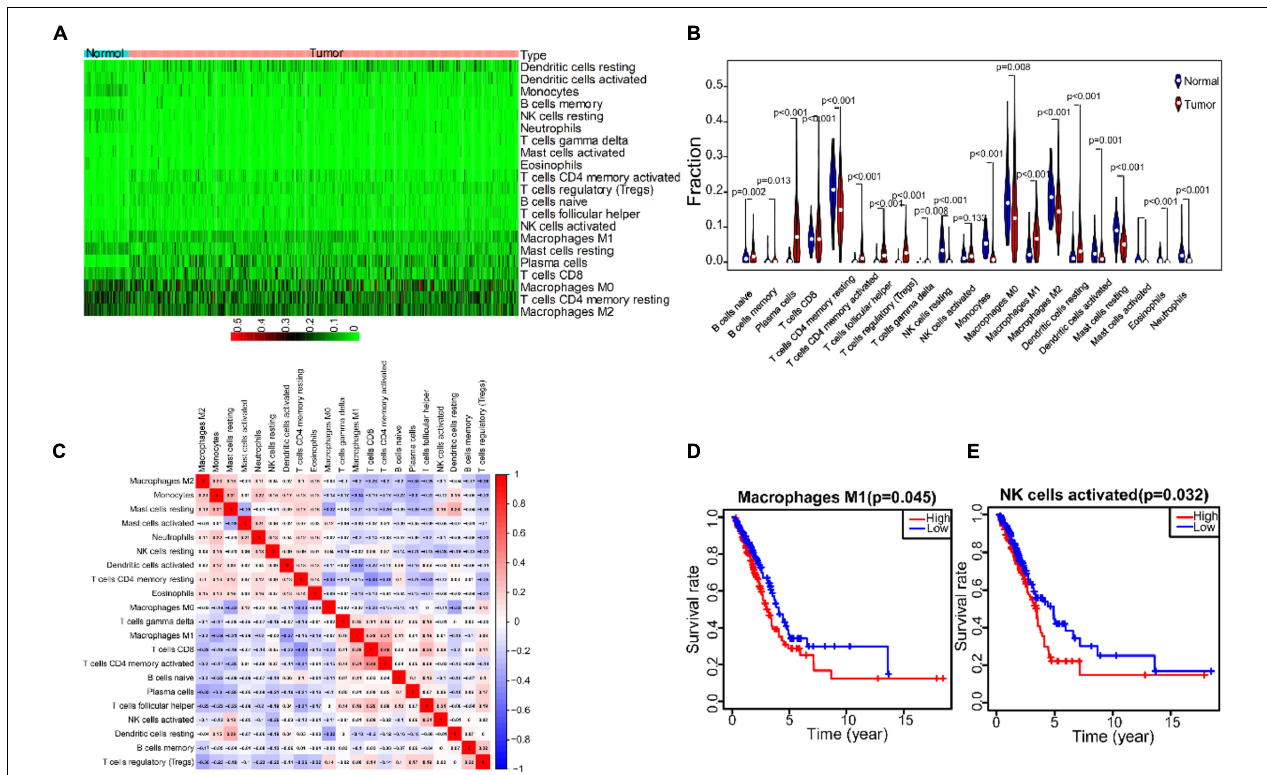
FIGURE 7 | The correlation analysis between TICs expression profile in LUDA tumor tissue and prognostic. (A) The expression heatmap of 21 immune cells in LUAD tumor tissue and normal tissue. (B) The expression violin diagram of 21 immune cells in LUAD tumor tissue and normal tissue. (C) The correlation test of 21 immune cells expression. (D) The correlation between M1 macrophages and the prognosis of LUAD patients. (E) The correlation between NK cells activated and the prognosis of LUAD